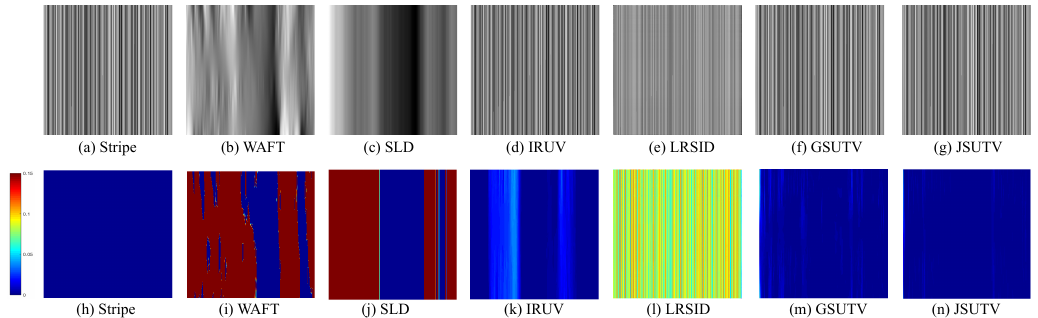
Figure 6. The estimated stripe of Case 9. ( a ) The true stripe. Estimated stripe images by ( b ) WAFT, ( c ) SLD, ( d ) IRUV, ( e ) LRSID, ( f ) GSUTV, and ( g ) JSUTV. The corresponding error images of ( h ) the true stripe,